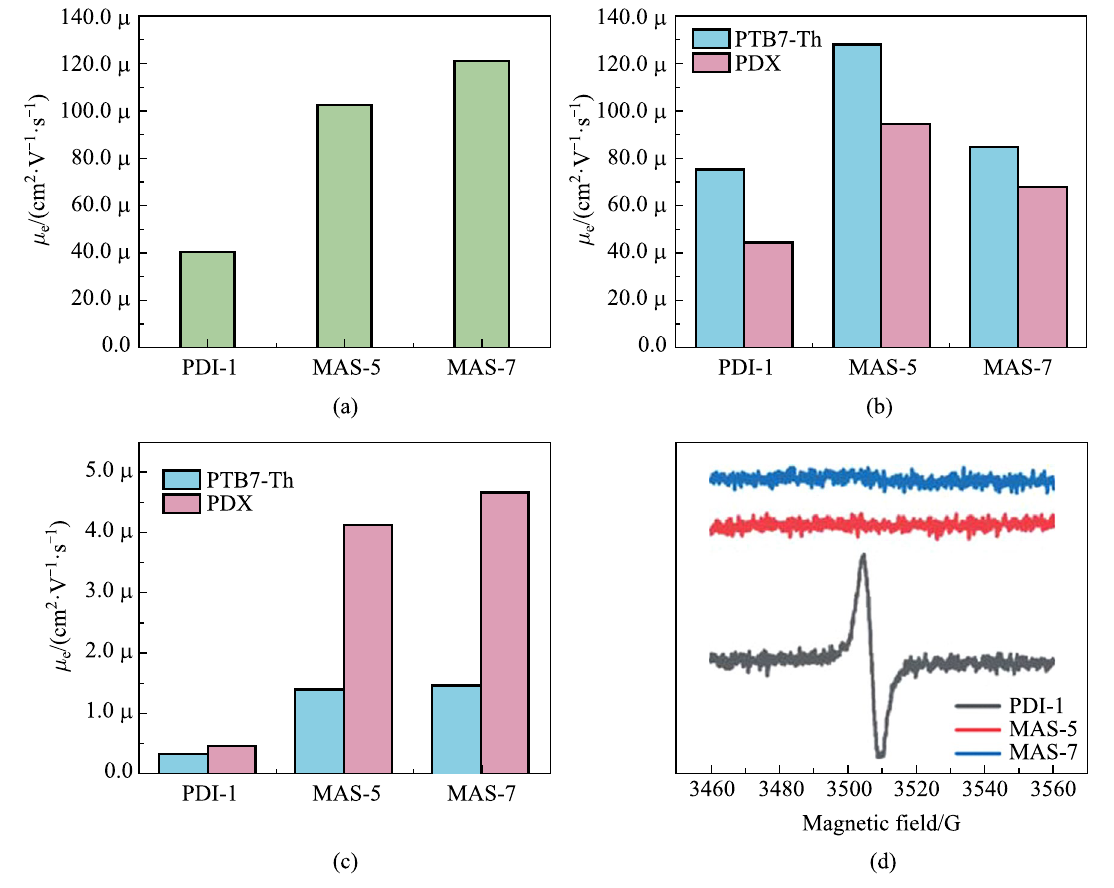
Fig. 6 a Electron mobility of PDI-1, MAS-5 and MAS-7 in pure films. b Hole and c electron mobility of optimized OSCs. d Electron paramag- netic resonance spectra of different acceptor